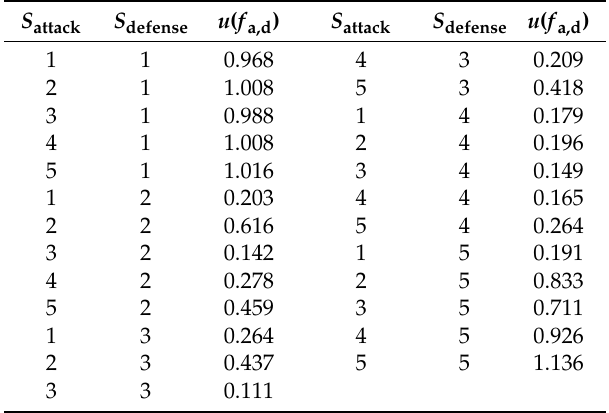
Table 4. Scalarized results for attack and defense interactions.